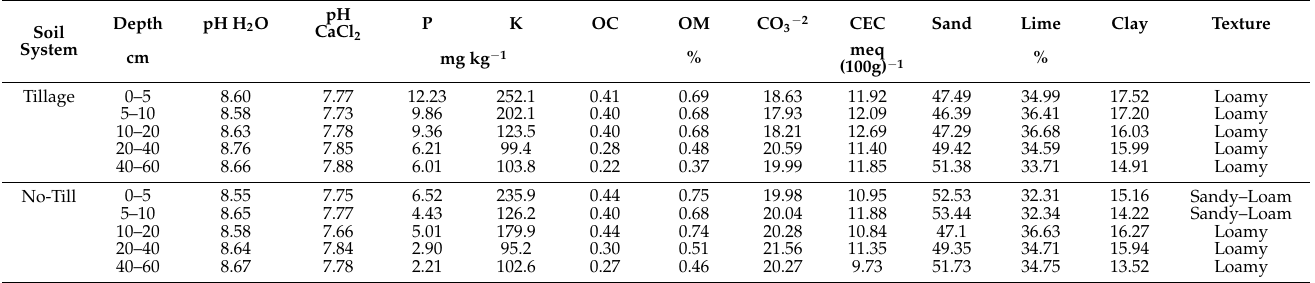
Table 3. The physical and chemical characteristics of different soil layers at the study